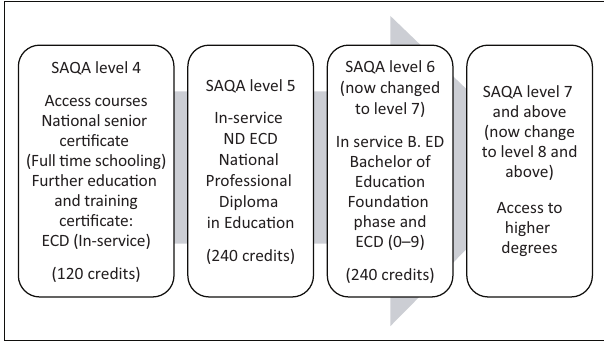
FIGURE 2: The Institute’s career